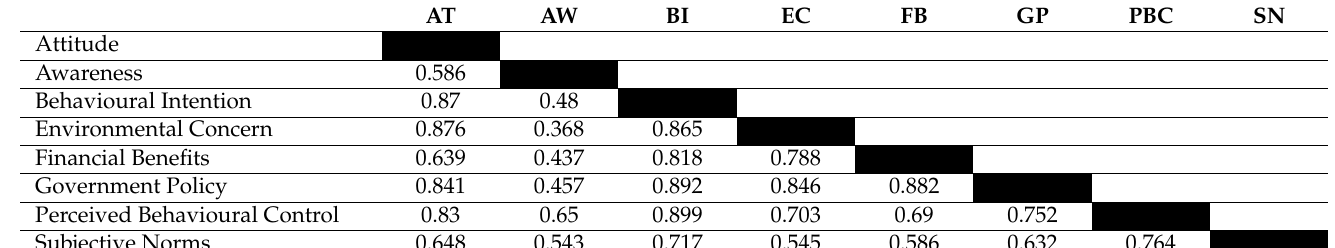
Table 5. Heterotrait–Monotrait Ratio (HTMT).